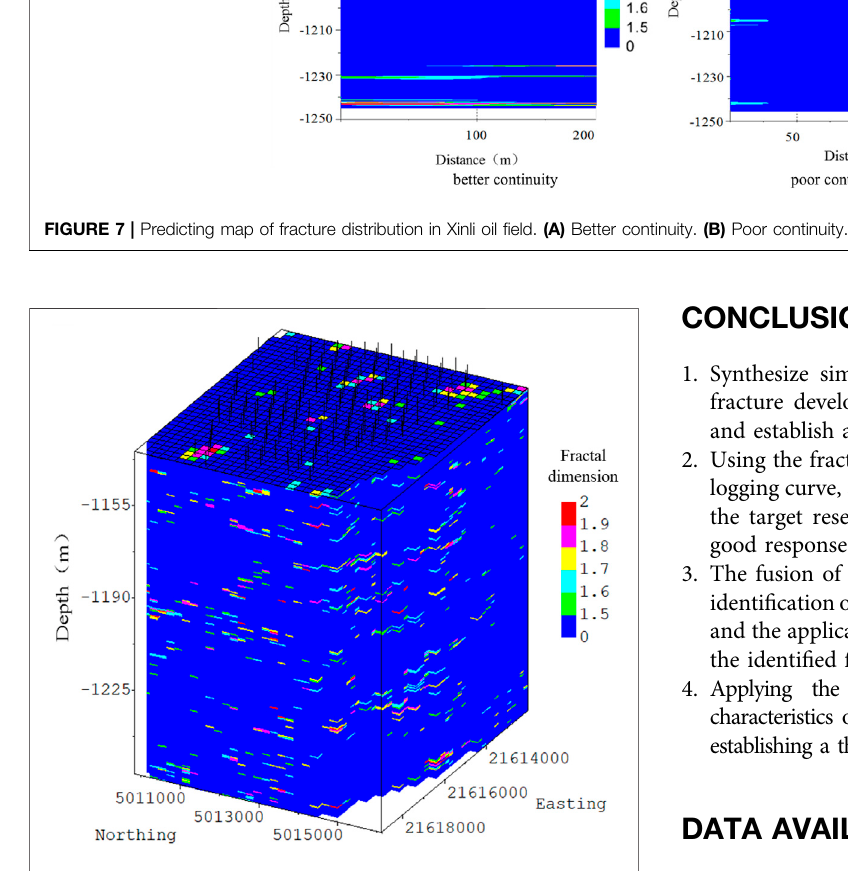
FIGURE 8 | Fracture ’ s 3-D model of the study